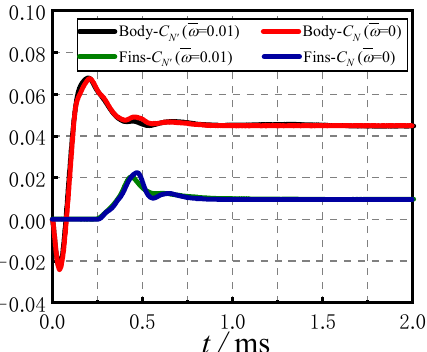
Figure 16. Comparison of aerodynamic coefficients in spinning and non-spinning